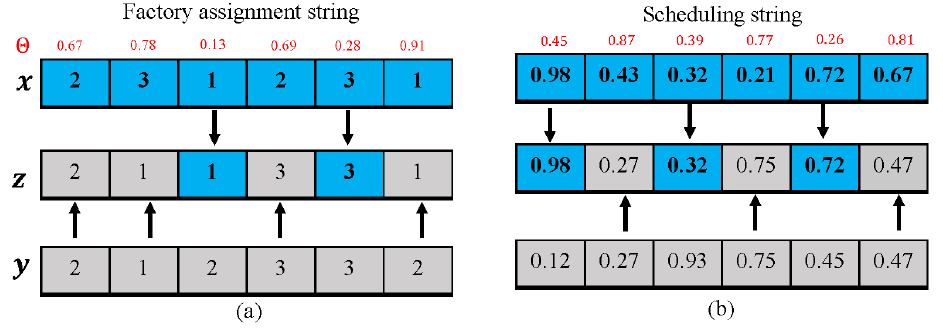
Figure 3. Example of a global search. ( a ) Factory assignment string; ( b ) Scheduling string.